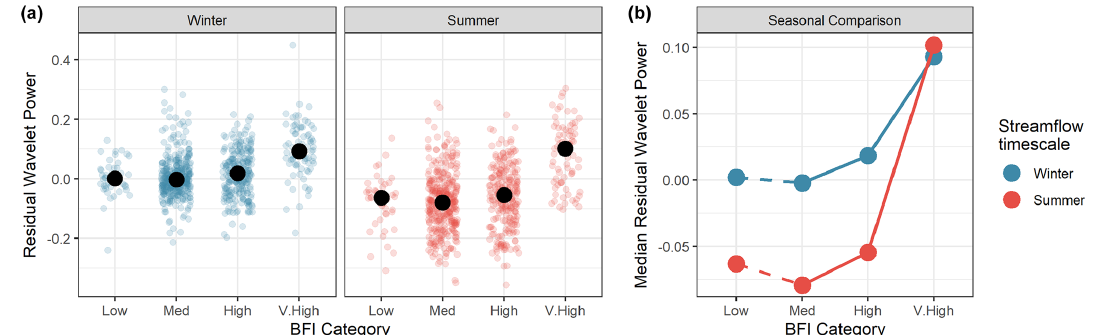
Figure 6. (a) Jittered scatterplots for residual wavelet powers in winter and summer, categorised by BFI; bold black points mark the average residual wavelet power for each BFI category. (b) Comparison of these median residual wavelet powers with significant changes between groups (shown as solid lines) and non-significant changes between groups (shown as dashed lines).